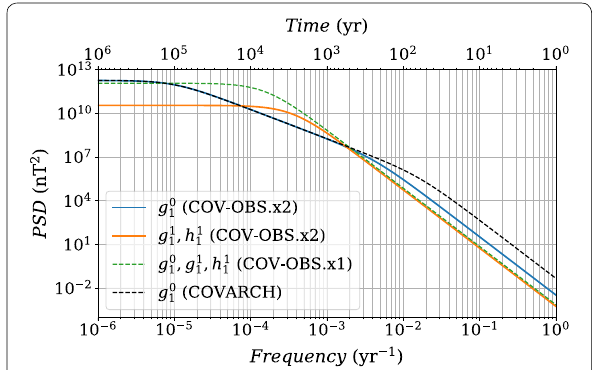
In italic font the three (resp. two) free parameters for the axial (resp. equatorial) dipole prior. We use the same parameters for h 1 1 and g 1 1